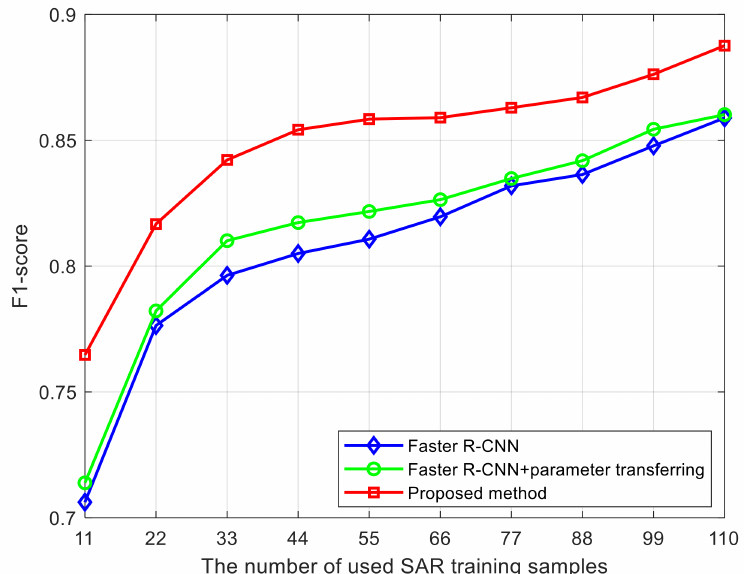
Figure 5. The experimental results with different numbers of used SAR training samples in the target